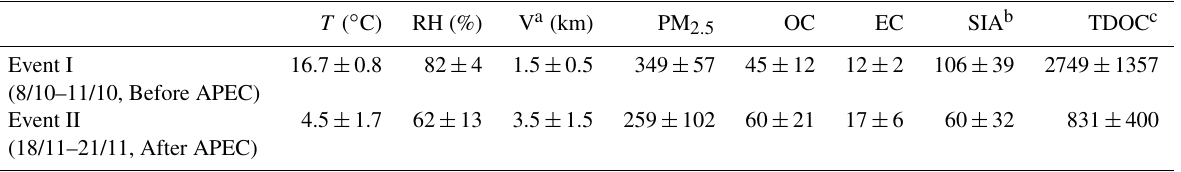
Table 4. Meteorological parameters and chemical compositions (µgm − 3 ) of two maximum PM 2 . 5 between two pollution episodes in Beijing.